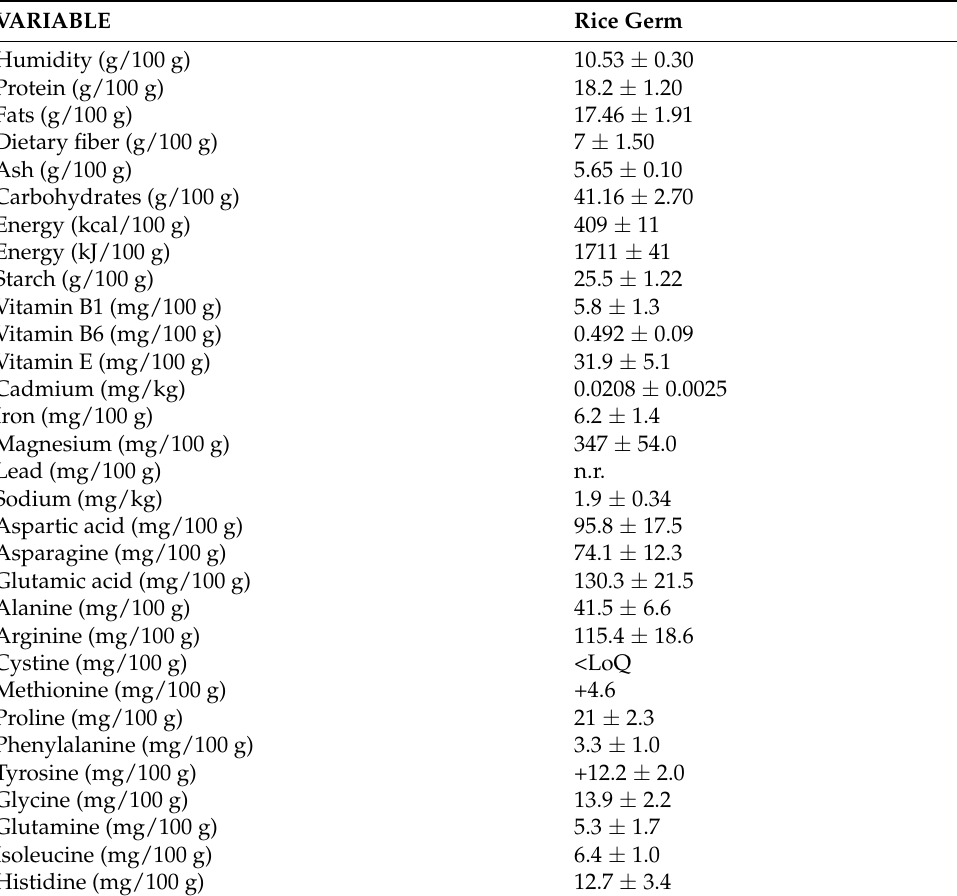
Table 1. Nutritional composition values of rice germ (RG) as the means ± standard